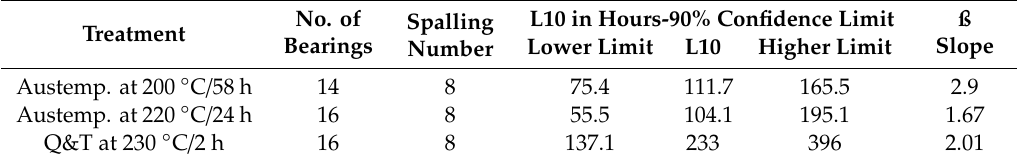
Table 8. Lifetime L10 calculations performed for components tested in artificial pollution tests.